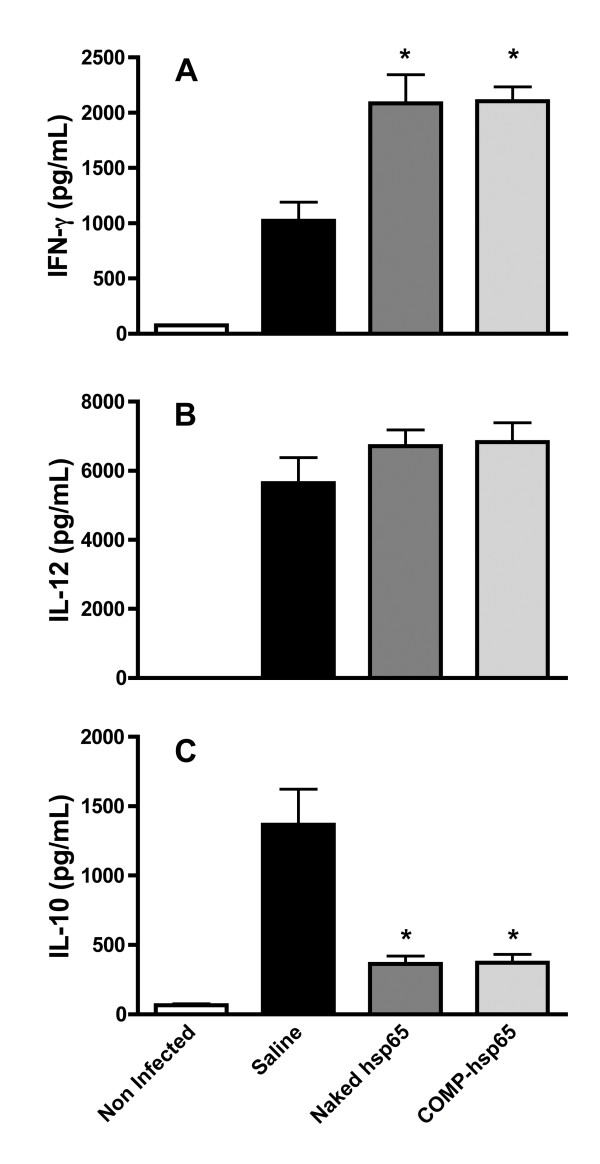
Cytokine production from the lung tissue of mice immunized with naked DNA-hsp65 or carried by liposome. Mice were immunized by intramuscular injection with naked hsp65 (400 μg) or by intranasal instillation with COMP-hsp65 (one dose of 25 μg). Thirty days after the last dose, mice were challenged intra-tracheally with M. tuberculosis H37RV and 30 days post infection, IFN-γ (A), IL-12 (B) and IL-10 (C) levels were determined by ELISA in lung homogenate. Data represent the mean ± SD of six mice per group of one of three independent experiments. *p < 0.01 were considered significant when compared to the saline group.